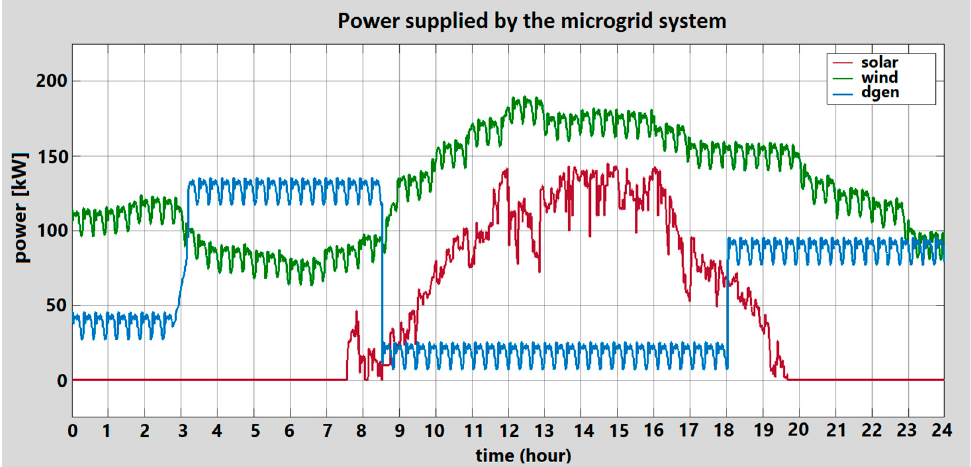
Figure 16. Power generation from different sources in the microgrid in a day.